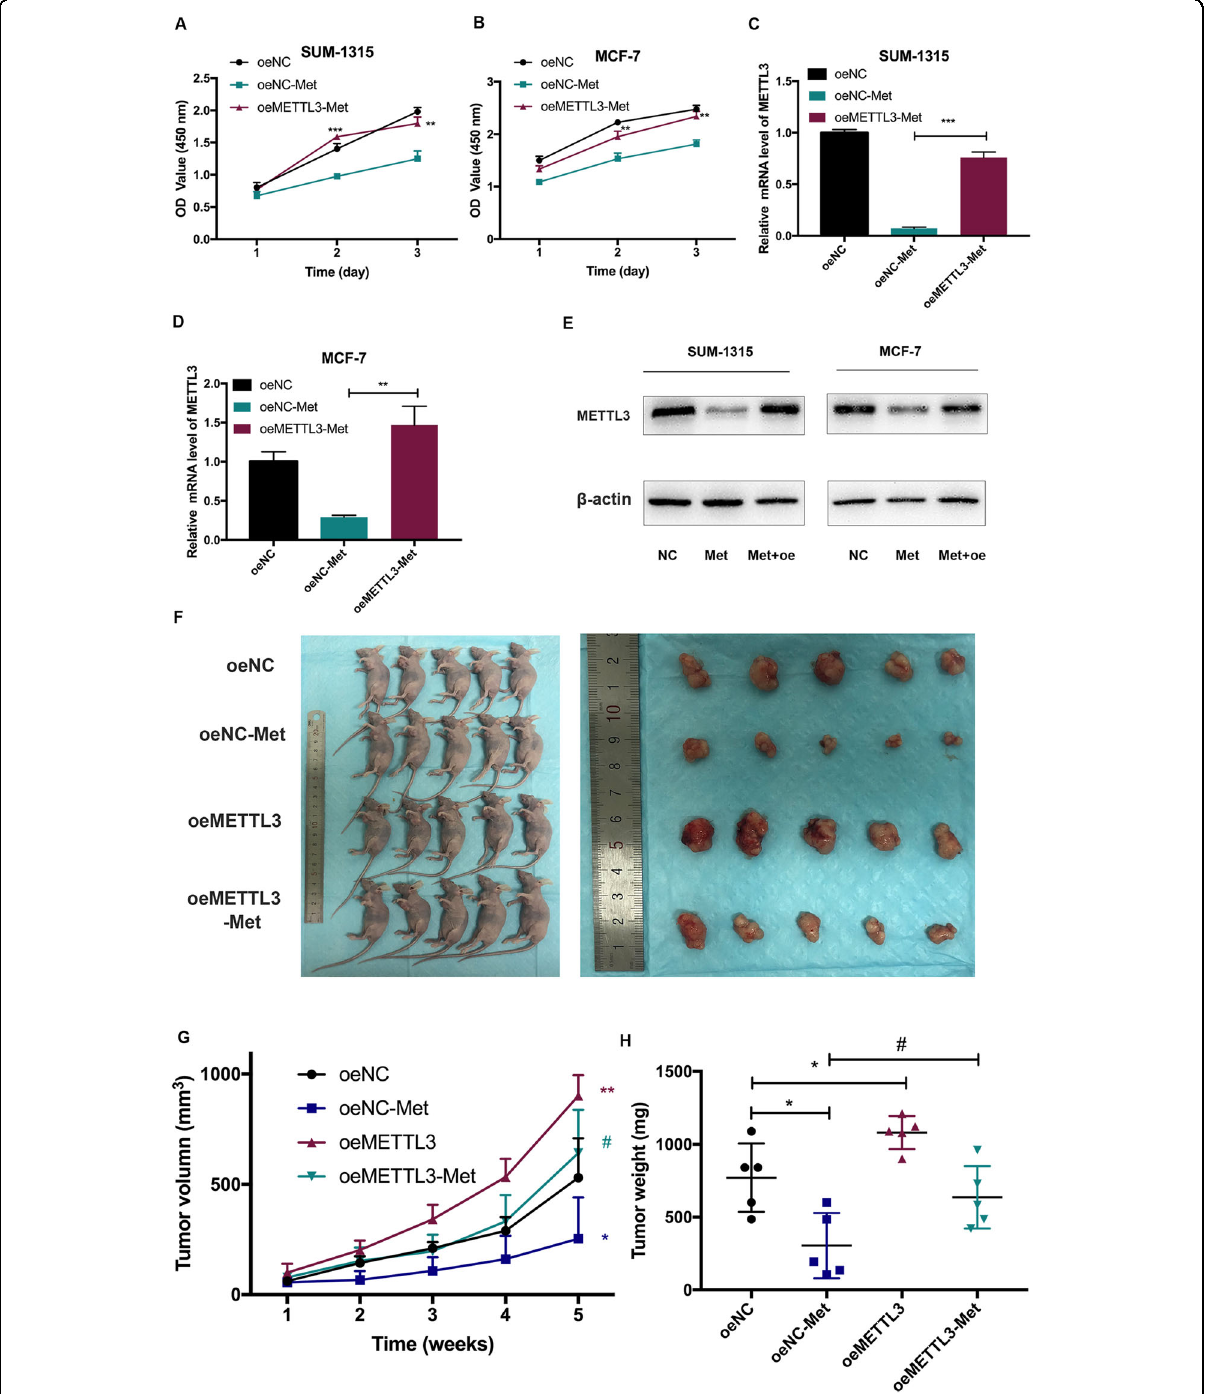
Fig. 3 Metformin inhibited breast cancer cell proliferation by downregulating METTL3. A , B Overexpression of METTL3 attenuated the cell growth inhibitory effect of metformin in SUM-1315 and MCF-7 cells by CCK-8 assay. C – E Overexpression of METTL3 attenuated the expression inhibition of METTL3 induced by metformin both in mRNA and protein level in SUM-1315 and MCF-7 cells. F – H Overexpression of METTL3 attenuated the inhibitory effects of metformin-inhibited tumor growth in vivo. Tumor weight and the tumor growth curve were measured in the four groups. Representative photographs ( F ) and quanti fi cation ( G , H ) were shown. oeNC, negative control; oeNC-Met, oeNC-Met, negative control group treated with metformin; oeMETTL3, METTL3 overexpression; oeMETTL3-Met, METTL3 overexpression group treated with metformin. Data represented the mean±SD, * p <0.05, ** p <0.01, *** p <0.001 vs. oeNC grou p , # p <0.05 vs. oeNC-Met group.